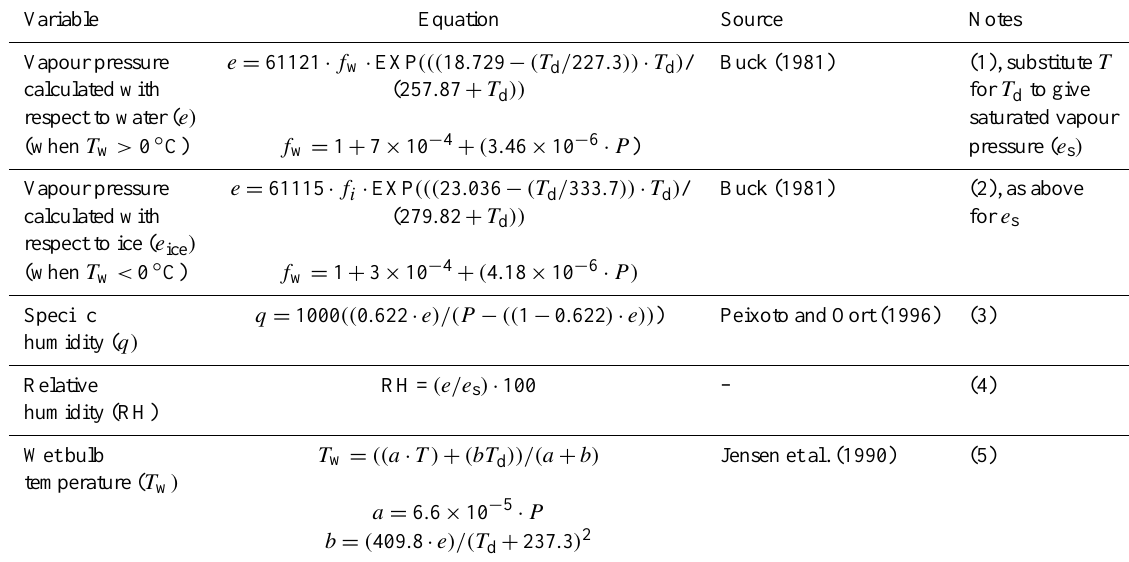
Table 1. Equations (1) to (5) used to derive humidity variables from dry bulb temperature and dew point temperature. Variable Equation Source